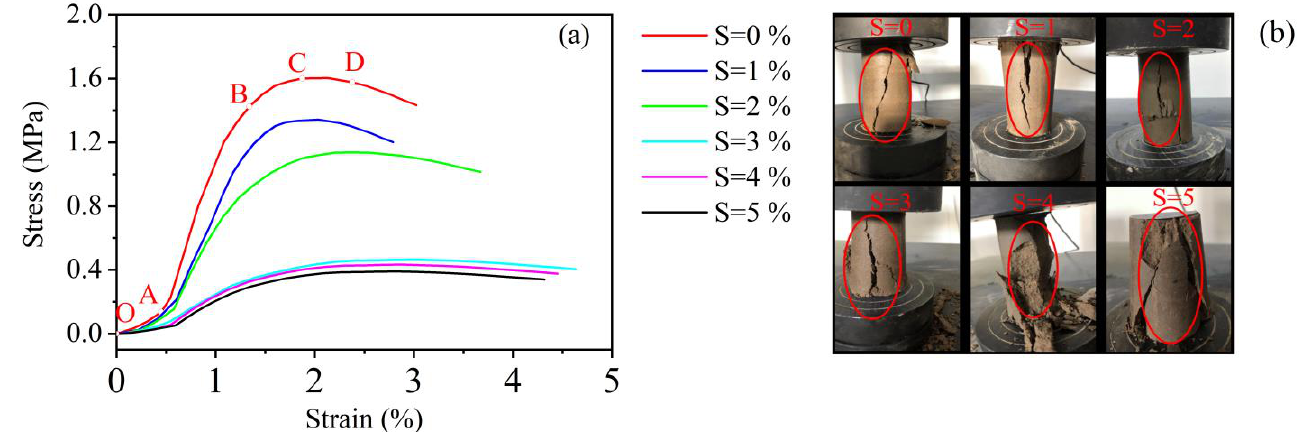
Figure 1. ( a ) Types of stress–strain curves (S represents salinity) and ( b ) compressive failure types for solidified saline soils with different salinities at an age of 14 days.